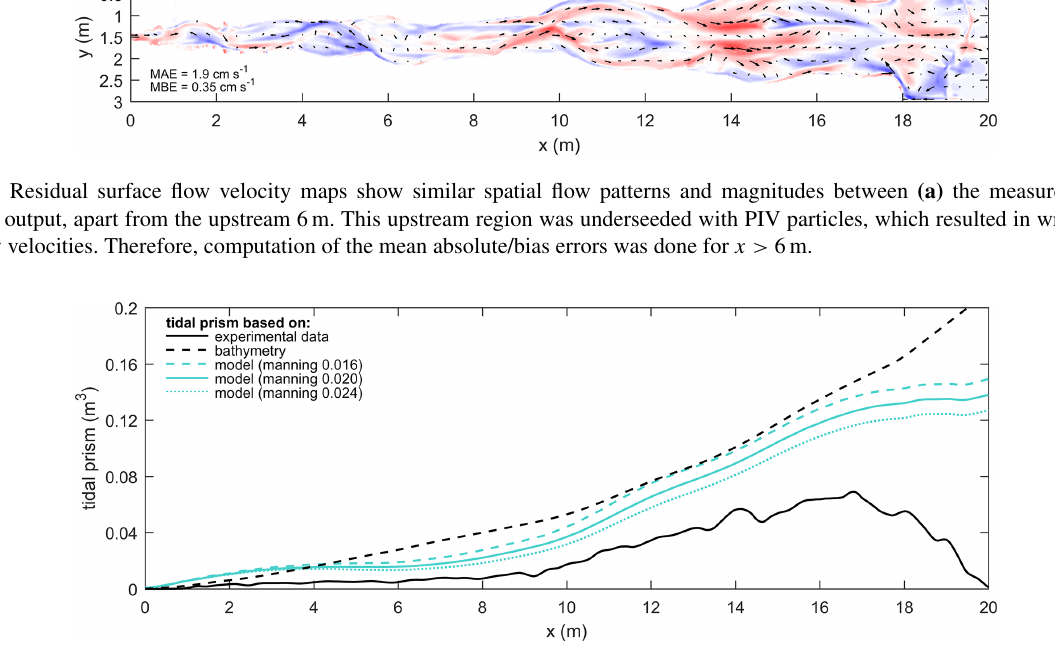
Figure 10. Tidal prism along the estuary based on experimental data, bathymetry and the model scenarios. Measured flow velocities were converted to depth-averaged velocities using Eq. (7). Tidal prism based on bathymetry (black dashed line) was computed as the cumulative volume of water along the estuary between high and low water levels imposed at the weir (i.e. with an amplitude of 4mm) (cf. Braat et al., 2018); this calculation ignores effects of friction and river